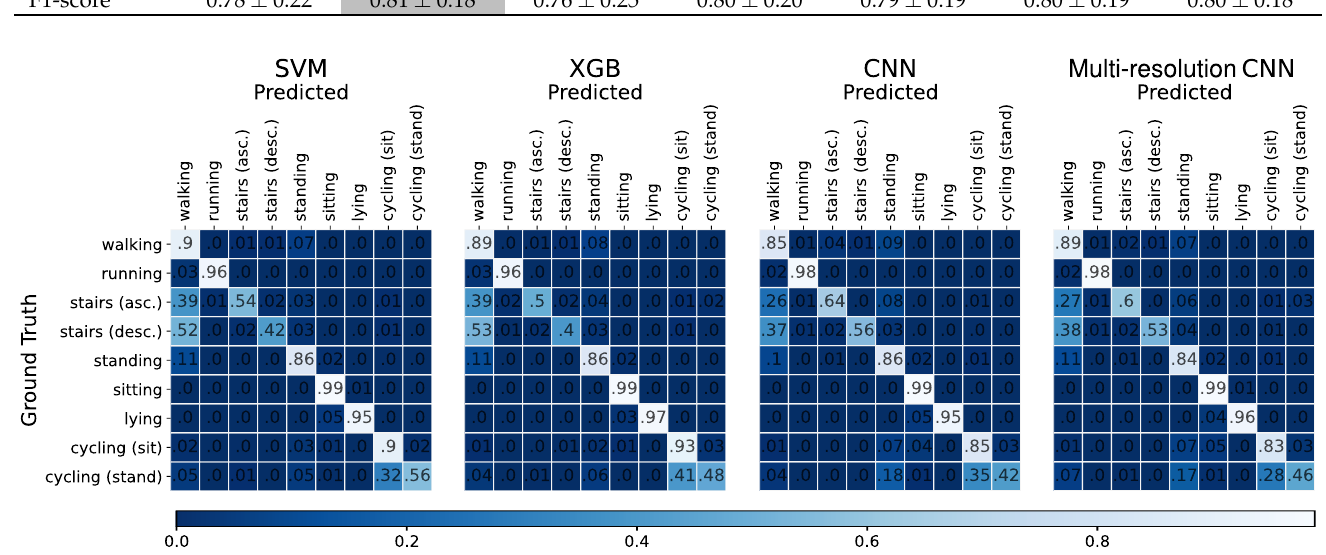
Figure 6. This figure shows four summed confusion matrices of the leave-one-subject-out cross-validation. The four considered models are the two best traditional machine learning approaches, SVM (left) and XGB (right of SVM), as well as the two best deep learning models CNN (left of multi-resolution CNN) and multi-resolution CNN (left). The rows show the ground truth labels and the columns the predictions. Additionally, the matrices are normalized such that each row sums up to one. The diagonal represents the proportion of correctly classified samples. The leading zero of each entry is